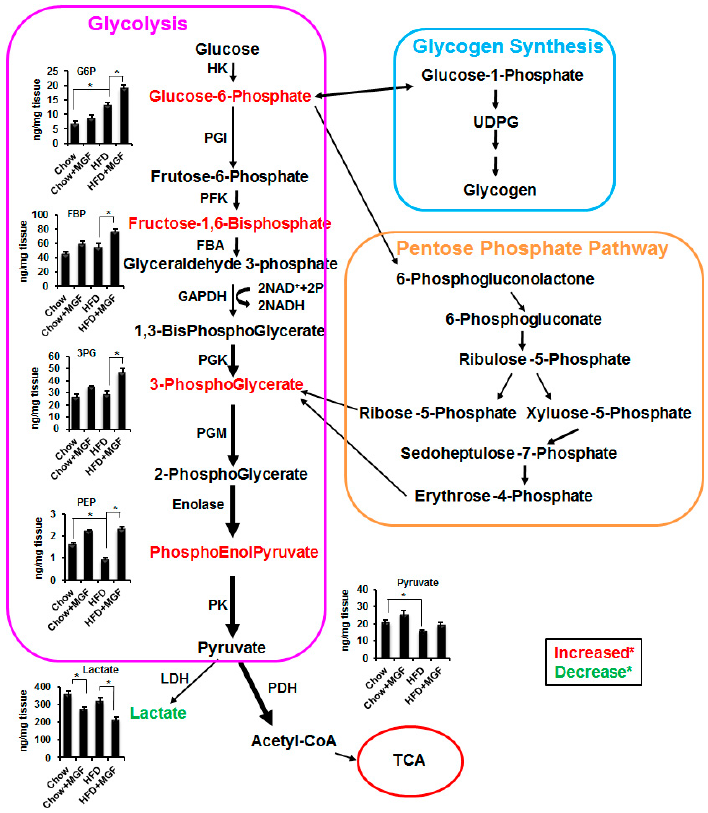
Figure 1. MGF accelerates glycolysis. Glucose metabolic pathways include glycogen synthesis, pentose phosphate shunt and glycolysis. Arrows in the glycolysis pathway indicate mangiferin directed metabolic flux from one product to the next. Arrows in other pathways mean change of one metabolic product to the other. Significantly altered metabolites are presented in bar graphs. Values are average ± SEM ( n = 6). * p < 0.05. HK, Hexose kinase; PGI, Phosphoglucose isomerase; PFK, Phosphofructokinase; FBA, Fructose-1,6-bisphosphate aldolase; GAPDH, Glyceraldehyde 3-phosphate dehydrogenase; PGK, Phosphoglycerate kinase; PGM, Phosphoglycerate mutase; PK, Pyruvate kinase; PEP, phosphoenolpyruvae; LDH, lactate dehydrogenase; PDH, pyruvate dehydrogenase; UDPG, urindine diphosphate glucose. Int. J. Mol. Sci. 2018 , 19 , 201